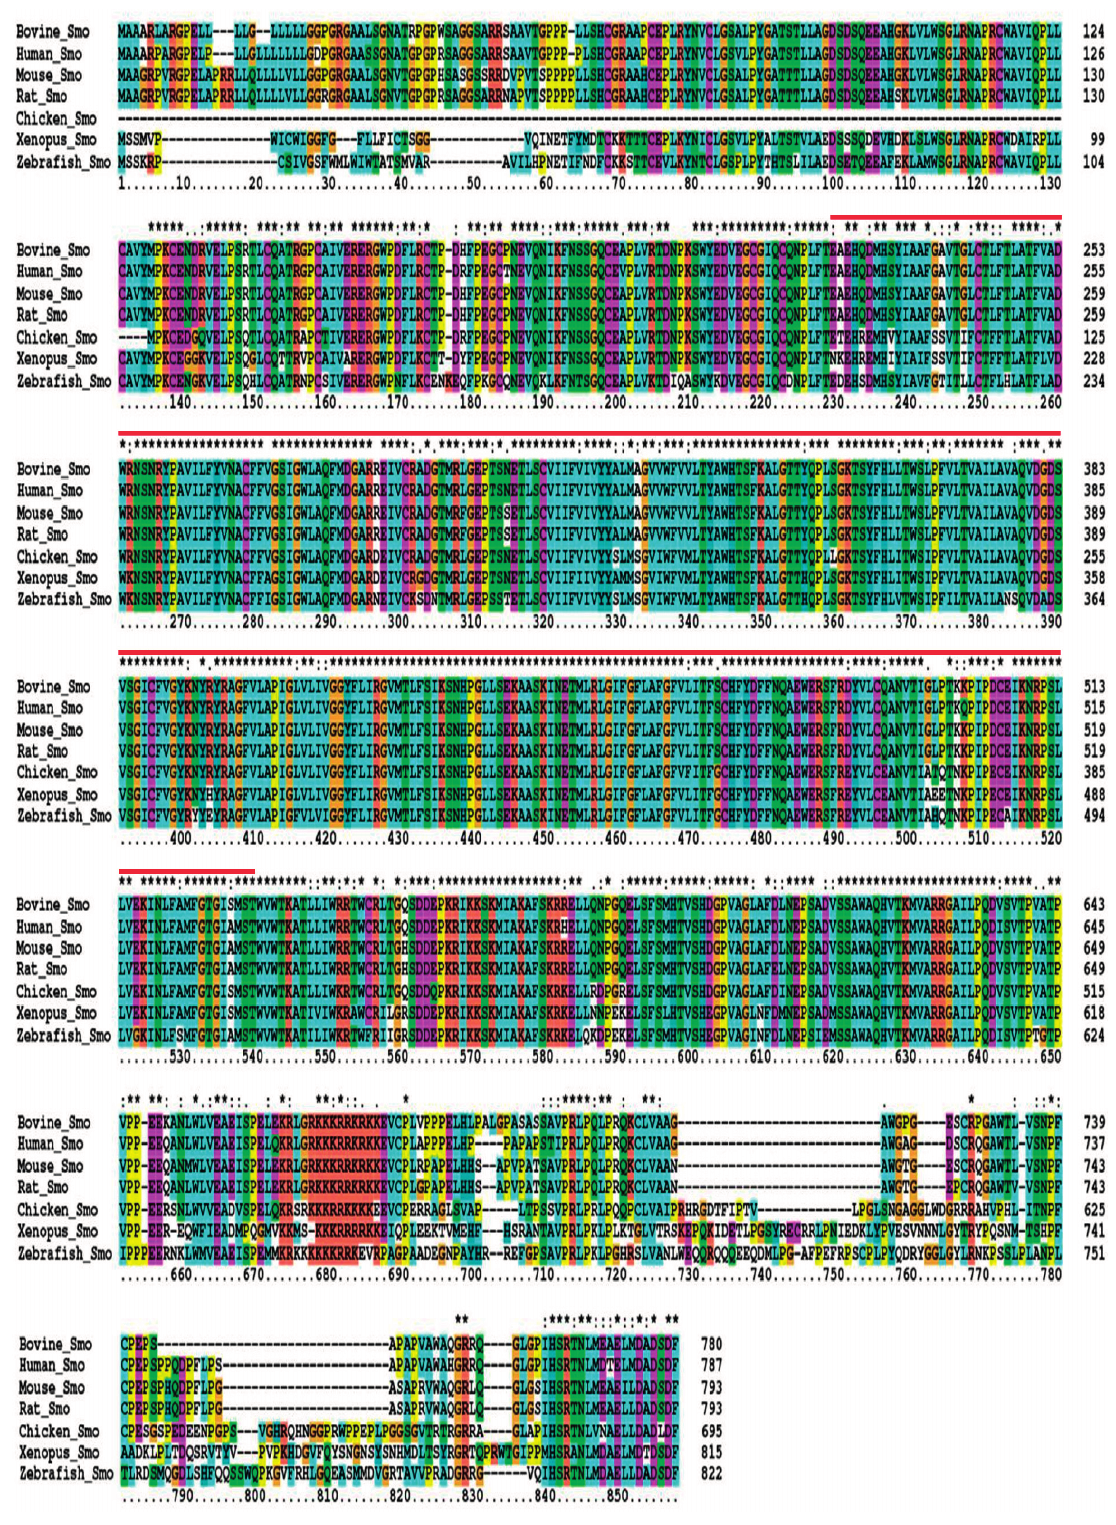
Figure 2. Aligned multiple amino acid sequences of the SMO gene in seven species. To make the assessment of alignment much easier, amino acid residues with different chemical properties are differentiated with different background colors. Asterisks denote positions that have been fully conserved; the “:” and “.” characters indicate positions where conservative and semi-conserved amino acid mutations have happened, respectively. And the red line highlights the inferred transmembrane